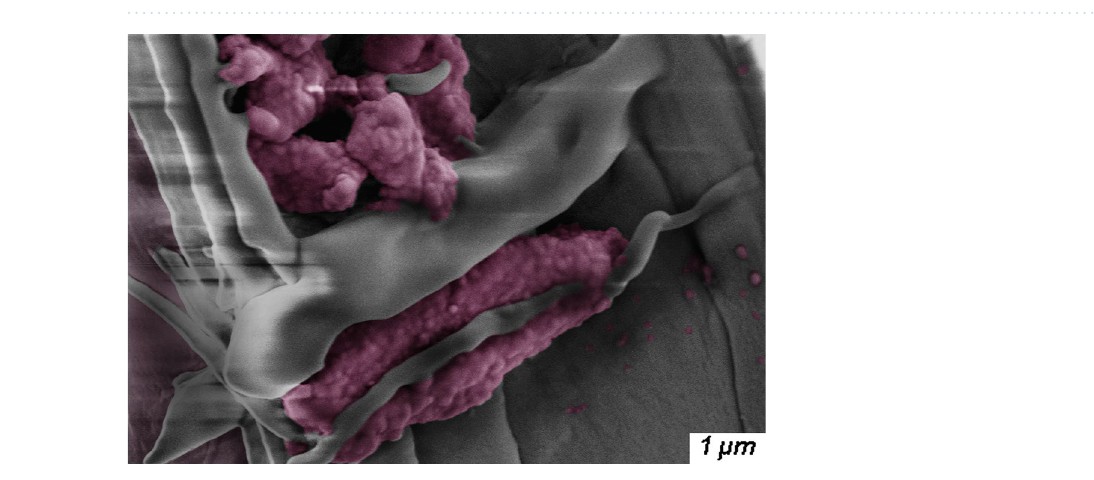
Figure 8. SEM image: the R-TD in R-PTC specimen.